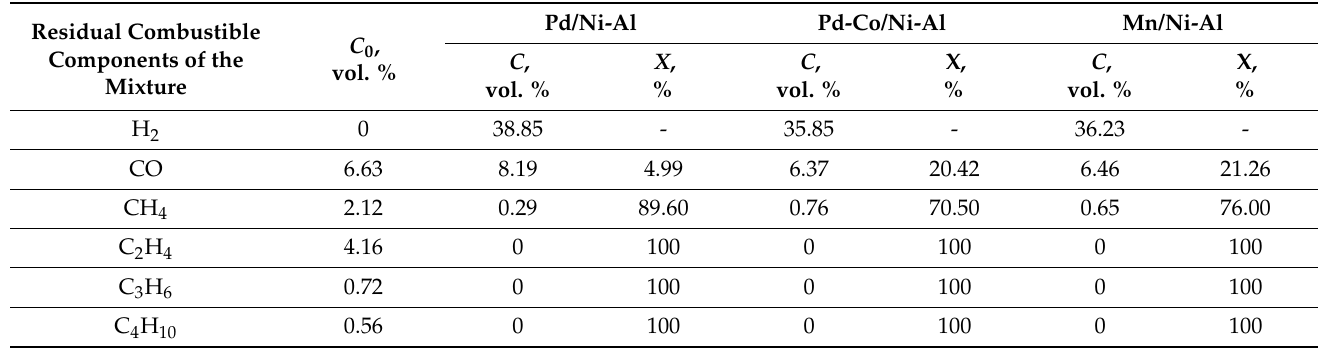
Table 8. Input and output parameters of the carbon dioxide and steam reforming of the products